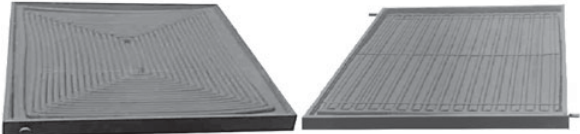
Figure 1 . The wing and labyrinth